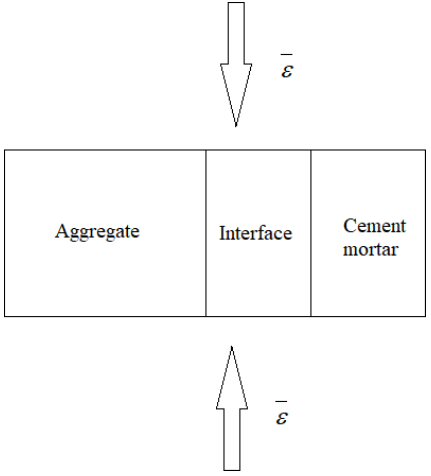
Figure 2: parallel model considering microscopic